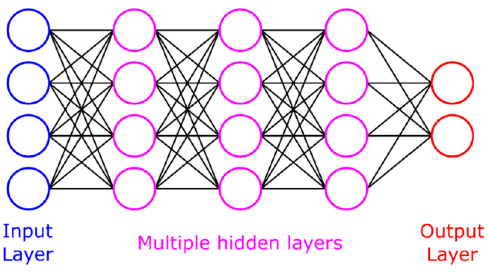
Figure 2. General diagram of neural network.